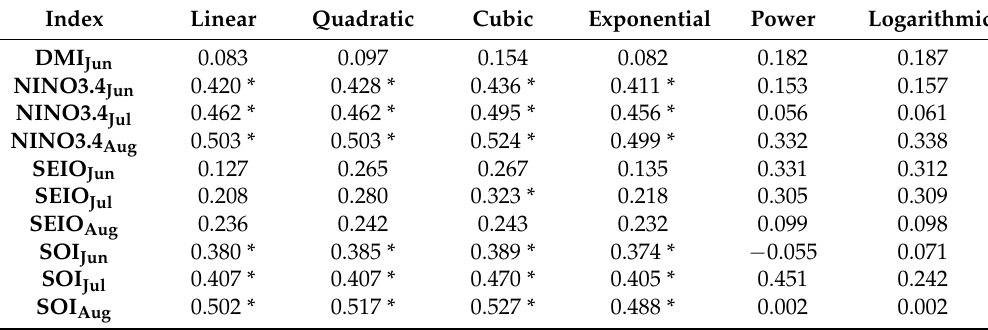
Table 1. Pearson correlations of the regression analysis for Ainslie Tyson St